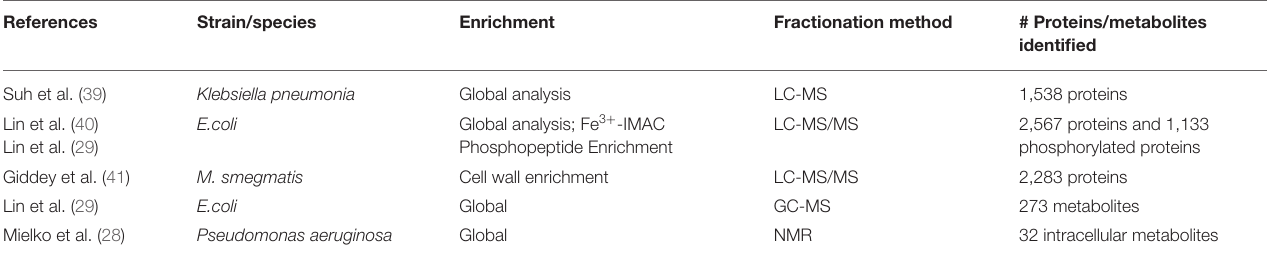
TABLE 1 | An overview of the methods and results generated in the five studies using mass spectrometry-based proteomics and metabolomics.